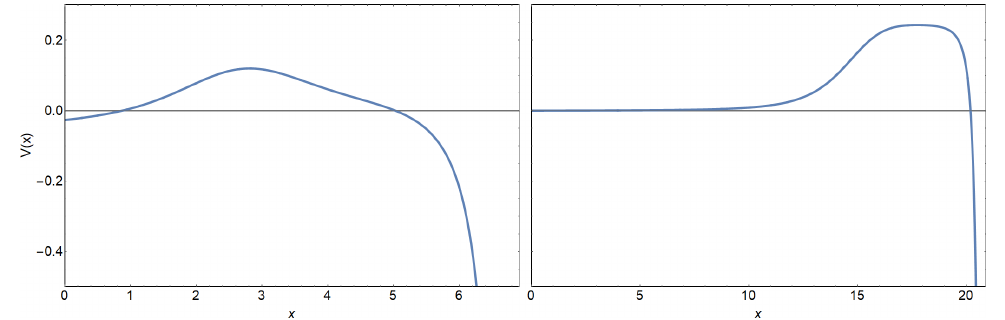
Figure 4 . The typical behavior of the “effective potential” V ( x ) at low temperature for L = 1 (left) and L = 9 (right). At x → 0 , V ( x ) ’ − 3 b 2 + b 2 (1 − 2 b ) x , which is negative. At x → c , it 4 is again negative and diverges as − ( c − x ) − 2 / 4 . Because V ( x ) is continuous, it must be bounded from